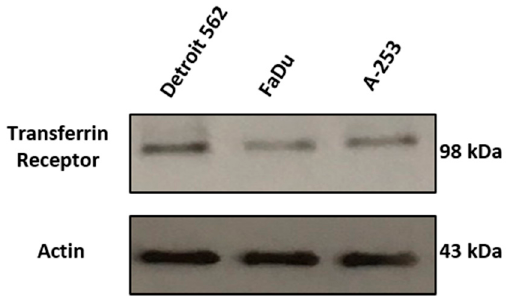
Figure 1. Transferrin receptor (TfR1) expression in the human HNSCC cell lines tested. β -actin was used as a loading control.